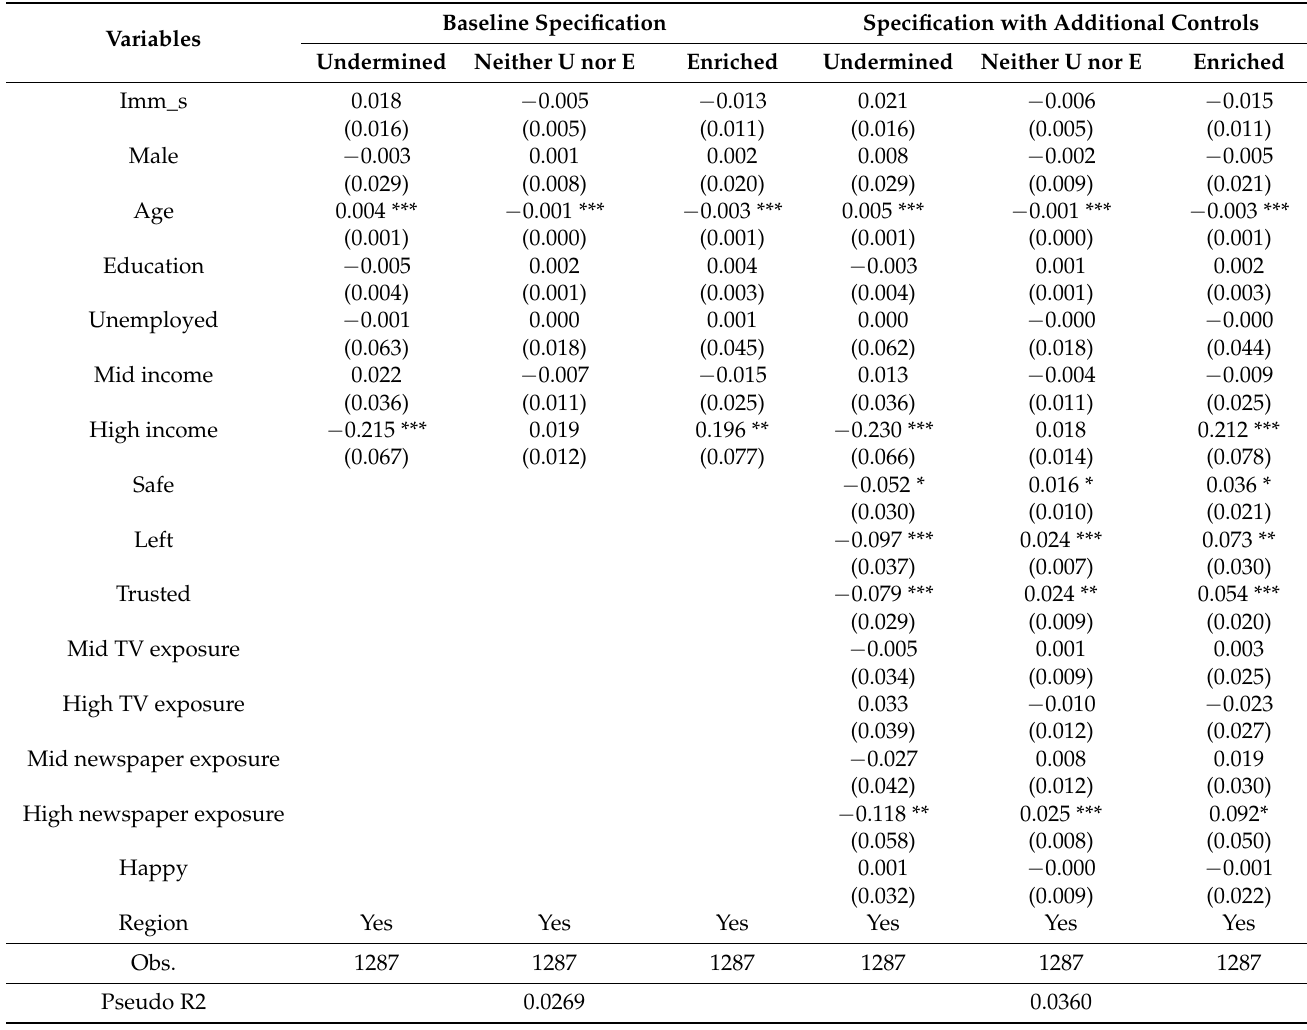
Table 8. Would you say that Turkey’s cultural life is generally undermined or enriched by people coming to live here from other